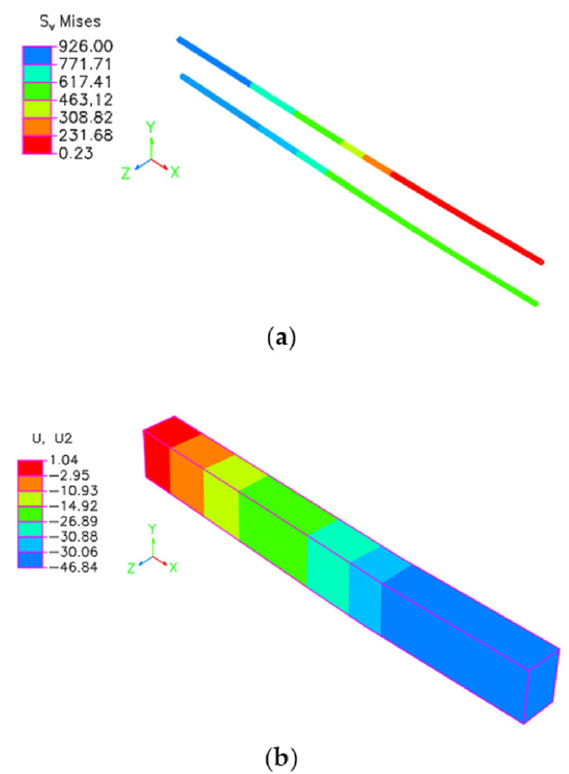
Figure 6. Stresses (MPa) in: ( a ) reinforced wooden beam reinforcement; and ( b ) vertical displacements (mm) of the reinforced wooden beam.